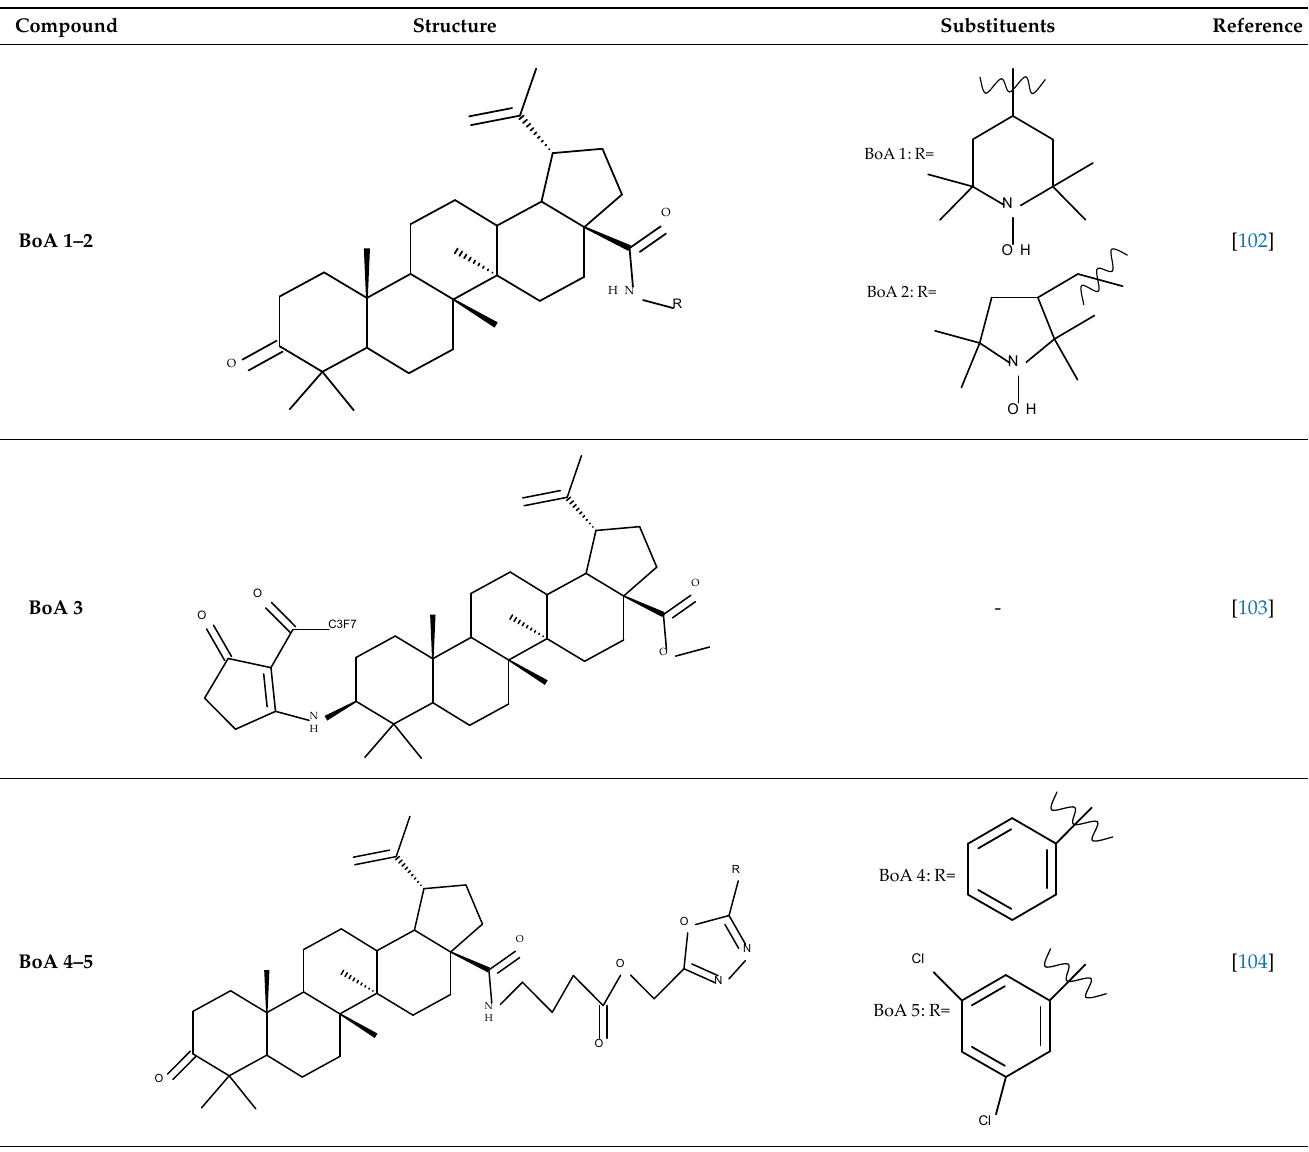
Table 5. Chemical structures of BoA derivatives.